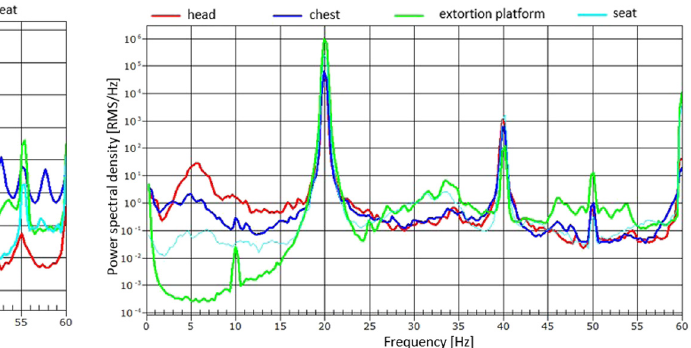
Figure 12: PSD for the excitation 20 Hz for the vertical